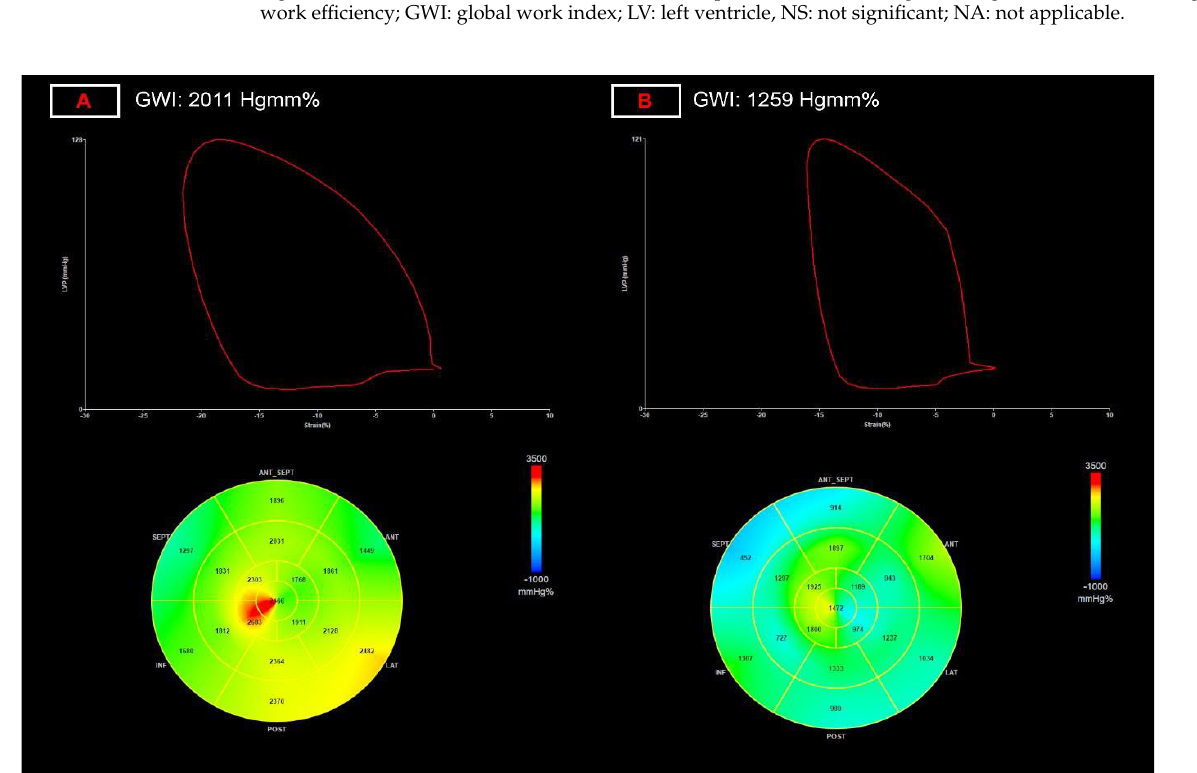
Figure 3. Representation of alterations of right ventricular free wall strain (FWS) measurement. ( A ) panel: normal right ventricular free wall strain of − 29.4%; ( B ) panel: decreased right ventricular free wall strain of − 16.8%, after COVID-19 infection.